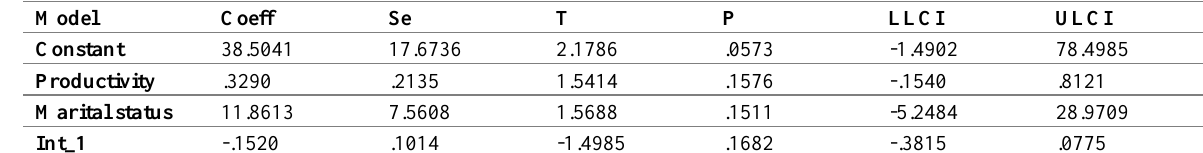
Table 11: Results of Moderation Effect Using Hayes Process Macro (Model 1)